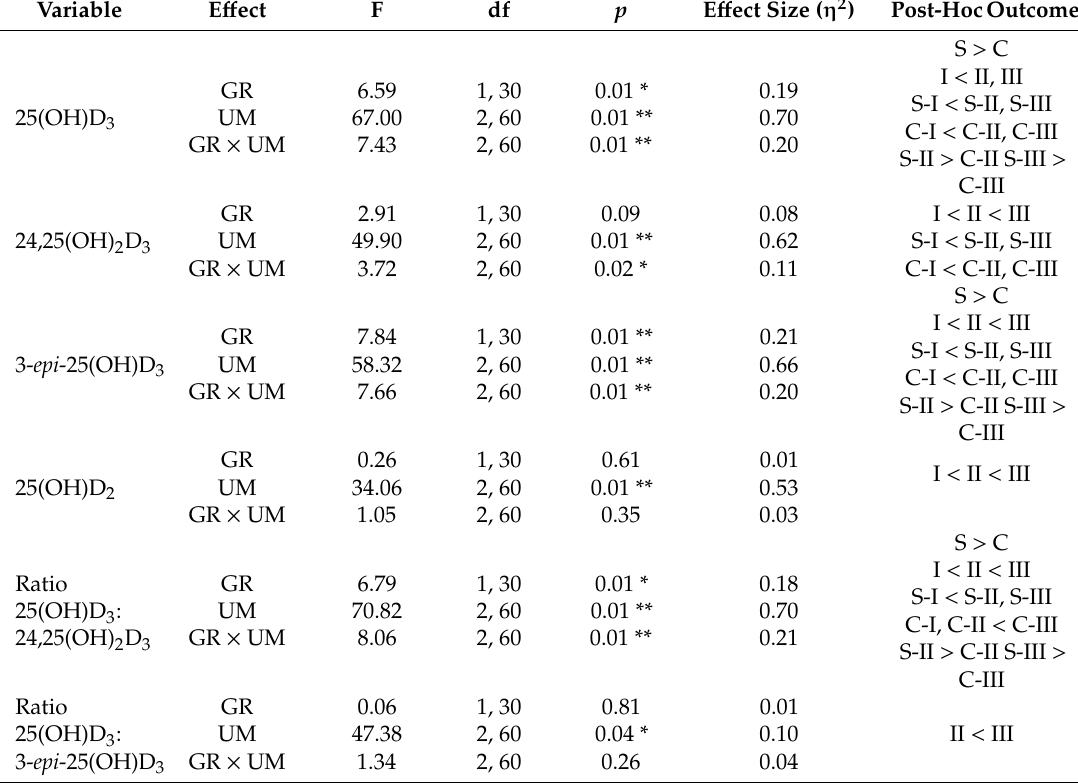
Table 2. Two-way (2 groups × 3 repeated measurements) ANOVA of the serum levels of vitamin D 3 induced by ultra-marathon